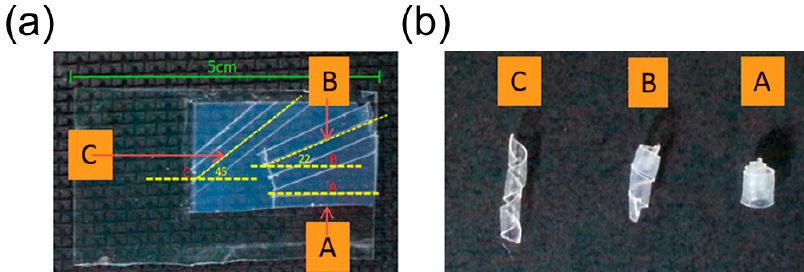
Figure 9. Formation of a helical shape triggered by water/acetone. ( a ) Ribbons cut at different angles (A: 0°; B: 22°; C: 45°) on a single-layer LCE film where the director is in the horizontal direction; ( b ) Formation of different helically coiled shapes of A, B and C in response to water exposure. Figure reprinted with permission from: ( a , b ) reference [42], American Chemical Society.